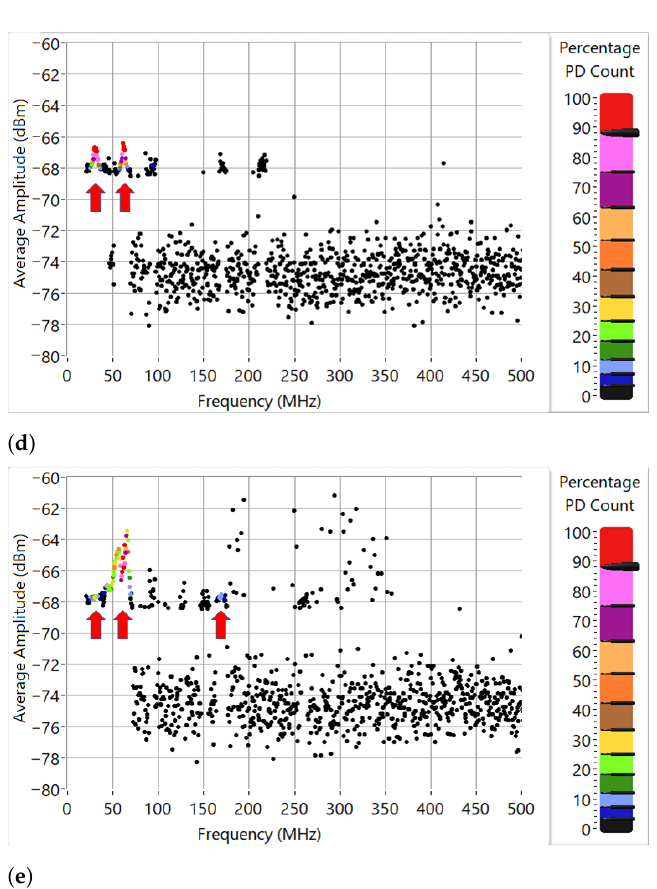
Figure 14. FRPD obtained from 0 to 500 MHz for different cases: ( a ) corona PD, ( b ) slot PD, ( c ) corona PD with concurrent slot PD, ( d ) background noise (high voltage power source not energized), and ( e ) background noise with an energized high-voltage power